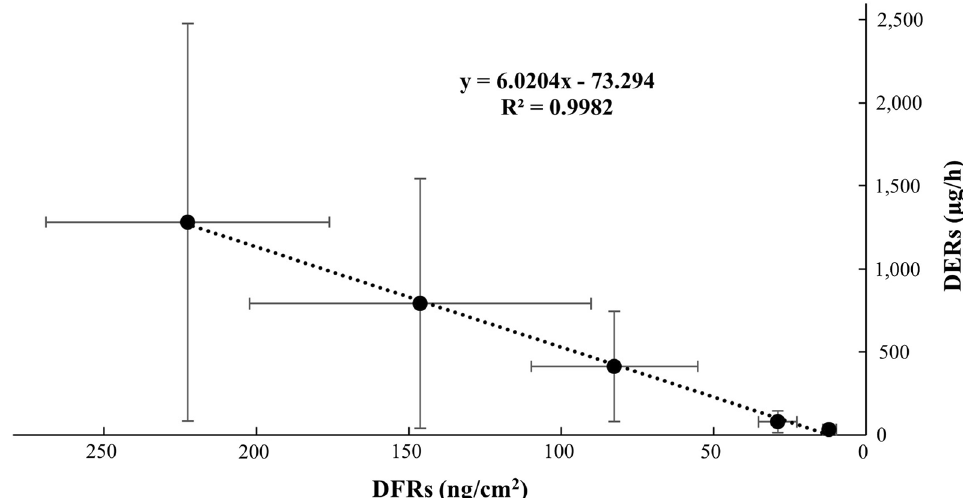
Fig. 1 Correlation between dislodgeable foliar residues (DFRs) and dermal exposure rates (DERs) to methidathion for harvesters in the cucumber